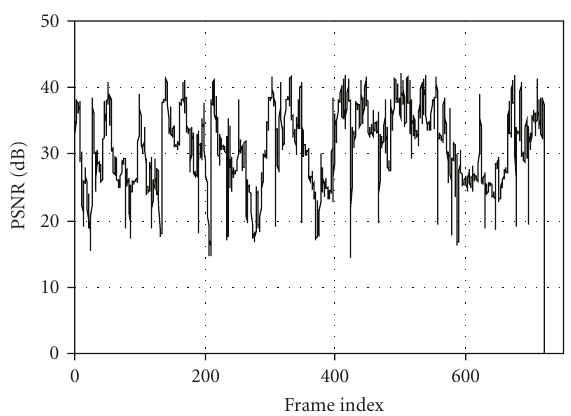
Figure 20: PSNR over the 750 frames of the input video, under a fixed power budget with an adaptive ARQ scheme